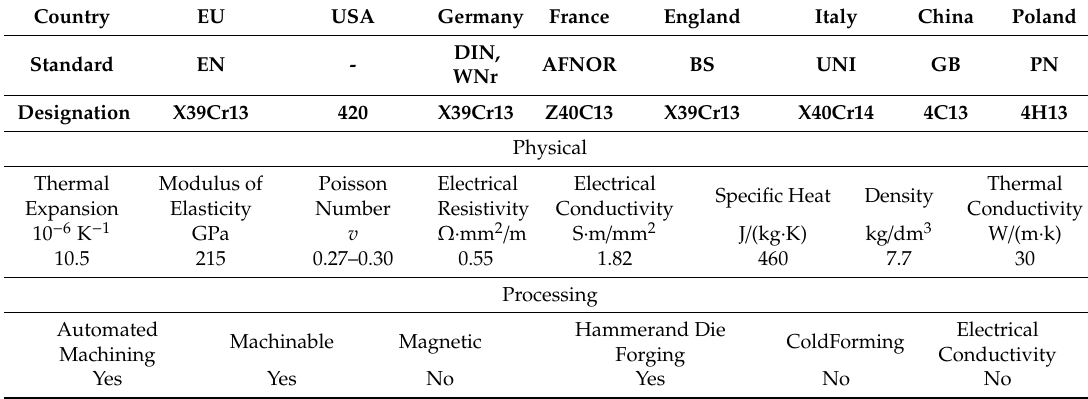
Table 2. The physical and processing properties of X39Cr13 high-carbon martensitic stainless steel.